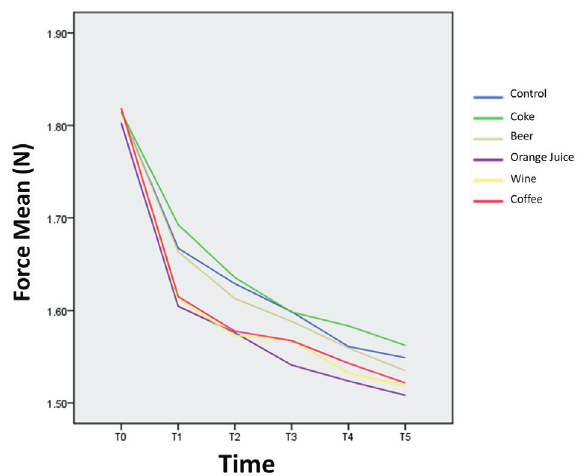
Figure 5- Mean force values of the intermaxillary elastics of each group over